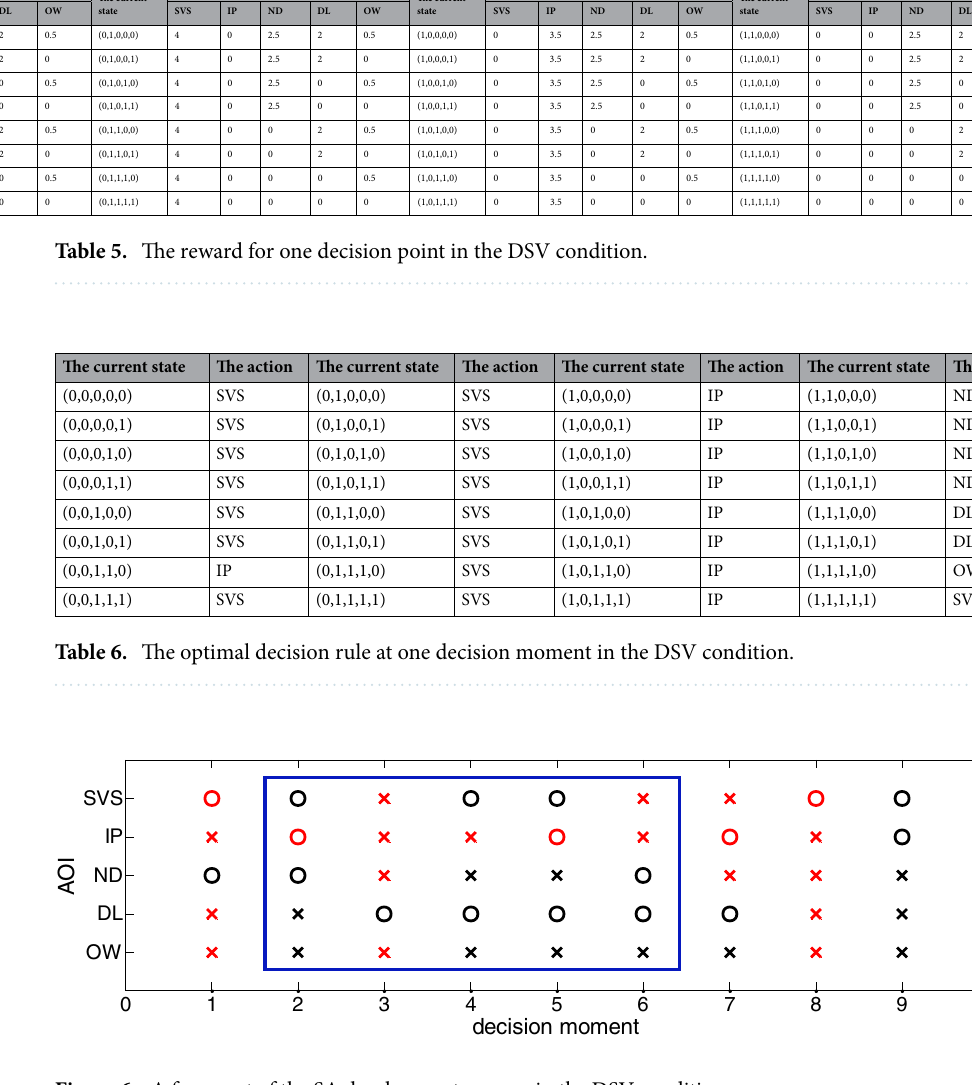
Figure 6. A fragment of the SA development process in the DSV